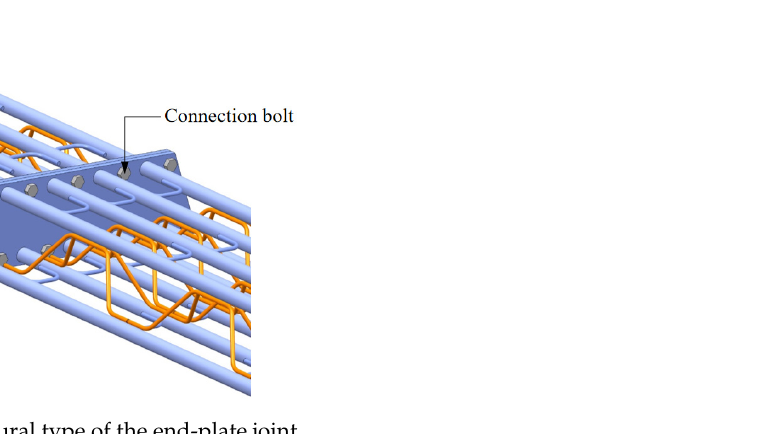
Figure 5. Structural type of the end-plate joint.